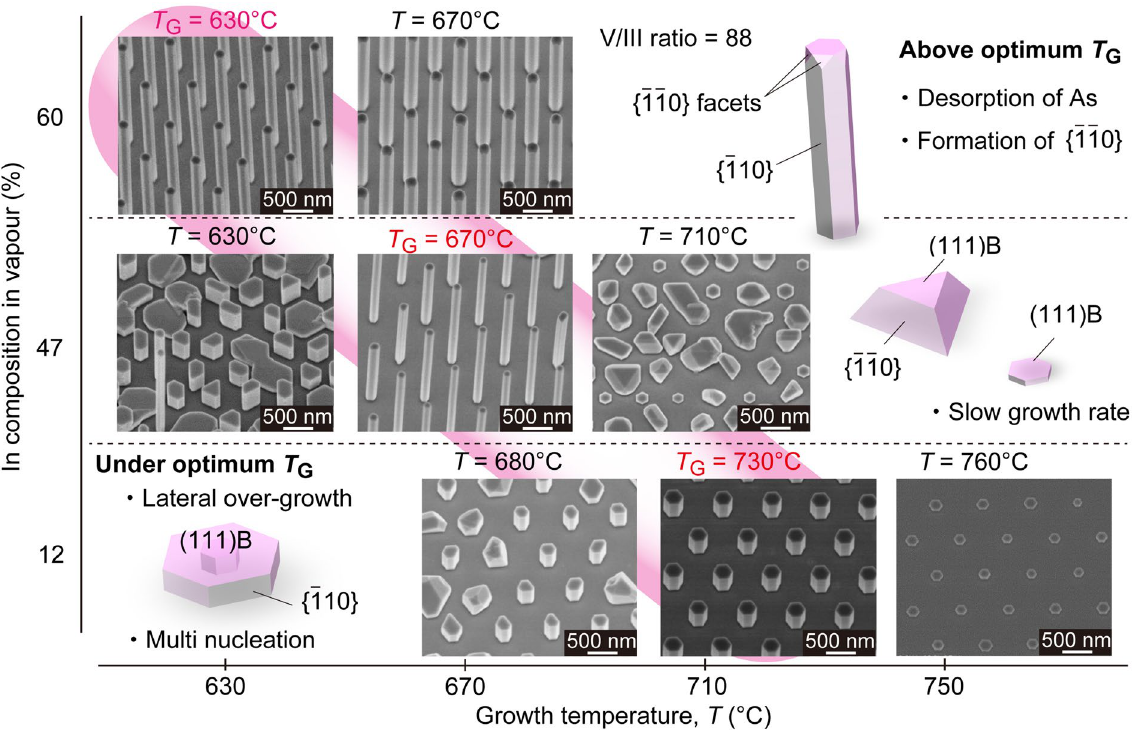
Figure 1. Selective-area growth of InGaAs on Ge(111). Growth morphologies of InxGa1 − xAs NWs on Ge(111) at various growth temperatures (T) and In compositions in vapour phase